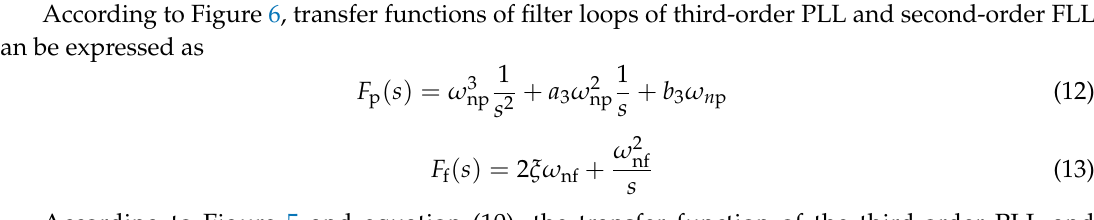
Figure 6. Block diagram of discrete time system of combined loop filter.